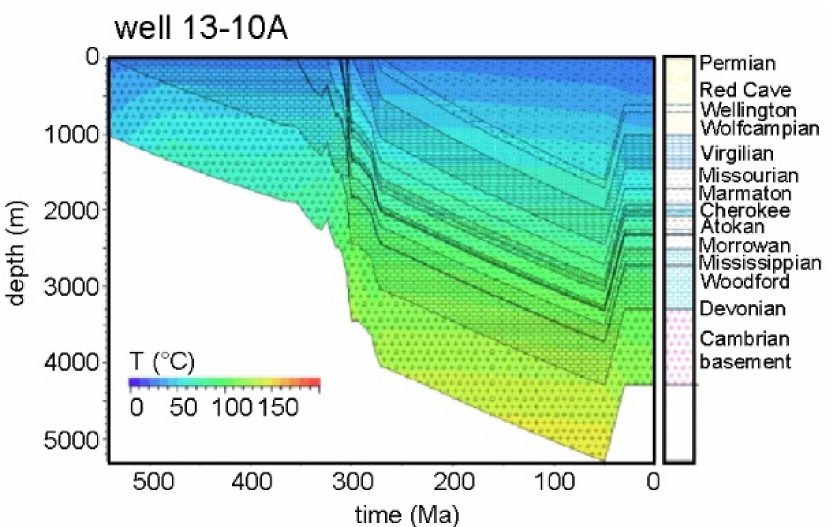
Figure 13. Burial and temperature history for well 13-10A. Before onset of the Laramide uplift, the source rocks from which hydrocarbons in Farnsworth Field are sourced (Table 1; Woodford, Morrowan, and Atokan) reached the oil/gas